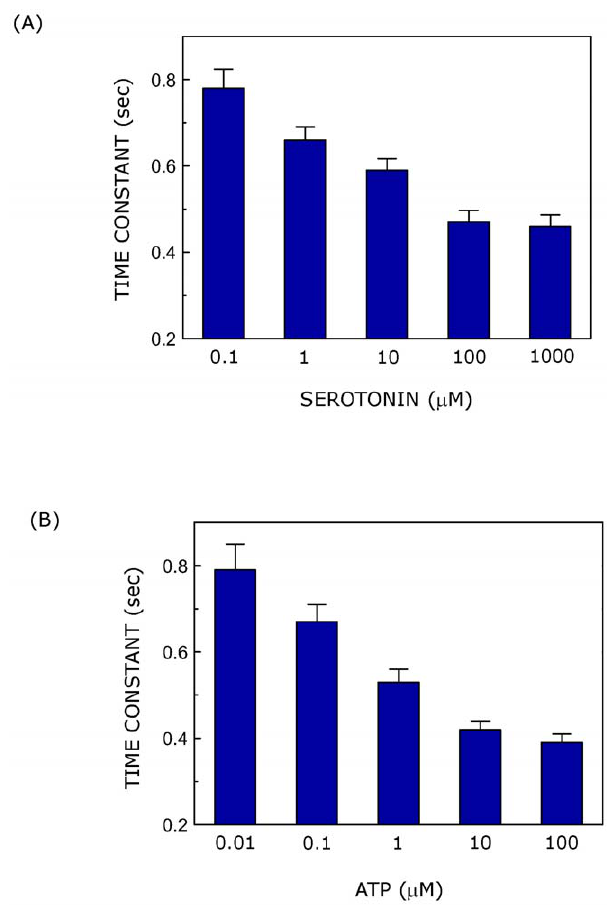
Figure 4. The rate of increase in cytosolic calcium levels depends on ligand concentration. The figure shows the apparent time constant for the rise phase of the first calcium spike induced with varying concentrations of either (A) serotonin or (B) ATP. R 2 values for fitting of the rise phase of calcium spikes with monoexponential function range from 0.94–1 in all cases. Data represent means 6 SEM of more than 30 cells from at least four independent experiments. See Materials and Methods for more